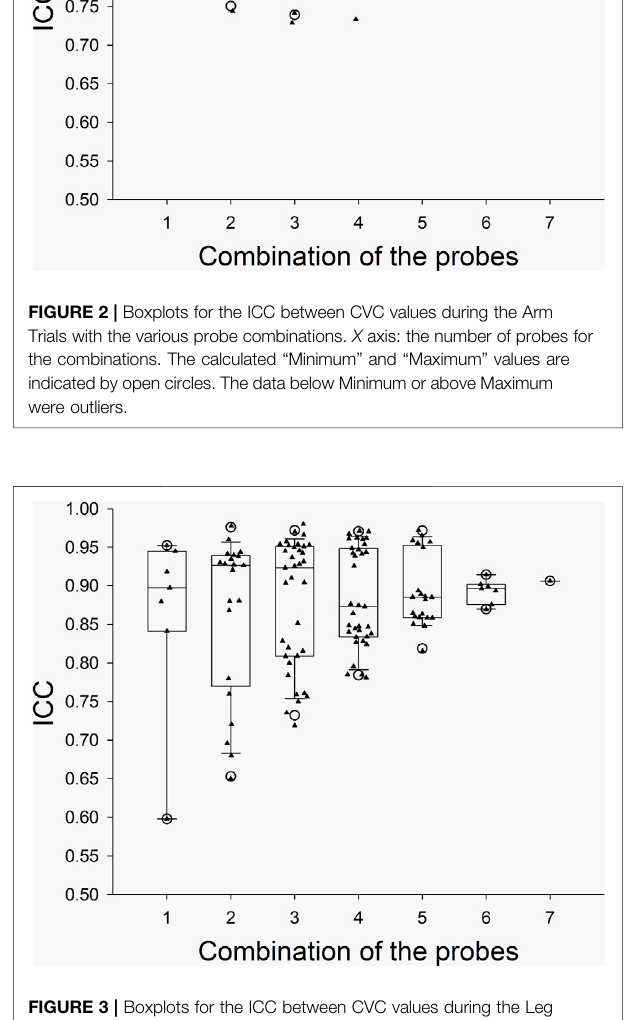
and Figure 3 , respectively. The fi ve-number summary of the distribution (i.e., minimum, Q1, median, Q3, maximum) of ICC values in the box and whiskers plots are shown in Table 4 . The minimum ICC values (i.e., the lowest detected ICC), generally improved with the addition of probes in both the arm, and leg.